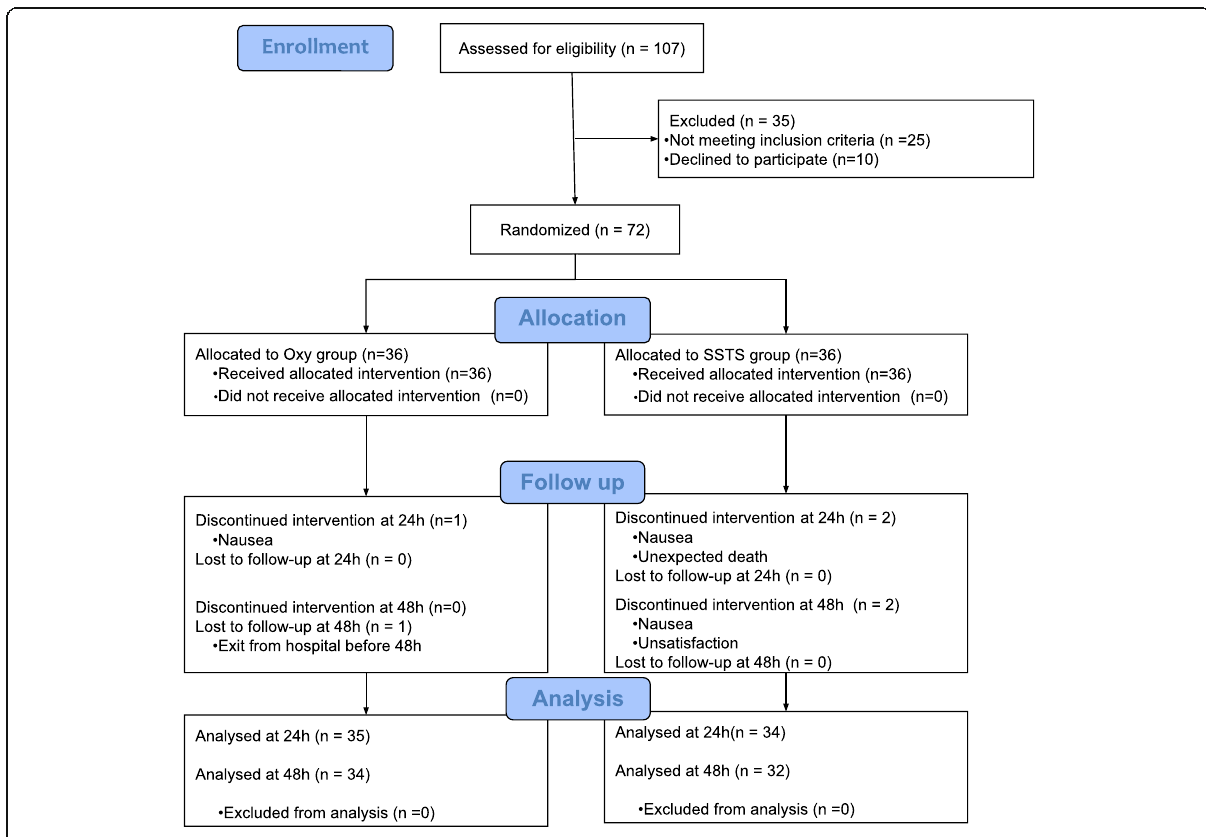
Fig. 1 Participant Flow (CONSORT diagram). SSTS = sufentanil sublingual tablet system